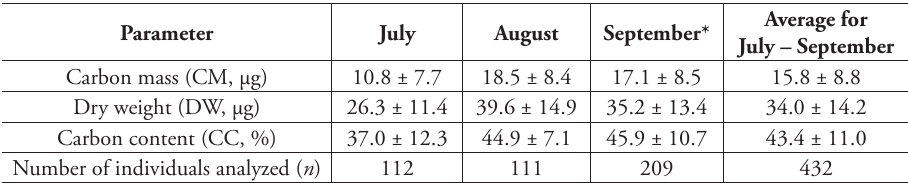
* Data from samples collected in September at two stations (St. 21 and St. P) were pooled because prelim- inary tests revealed high similarity of both data sets ( p <0.001).